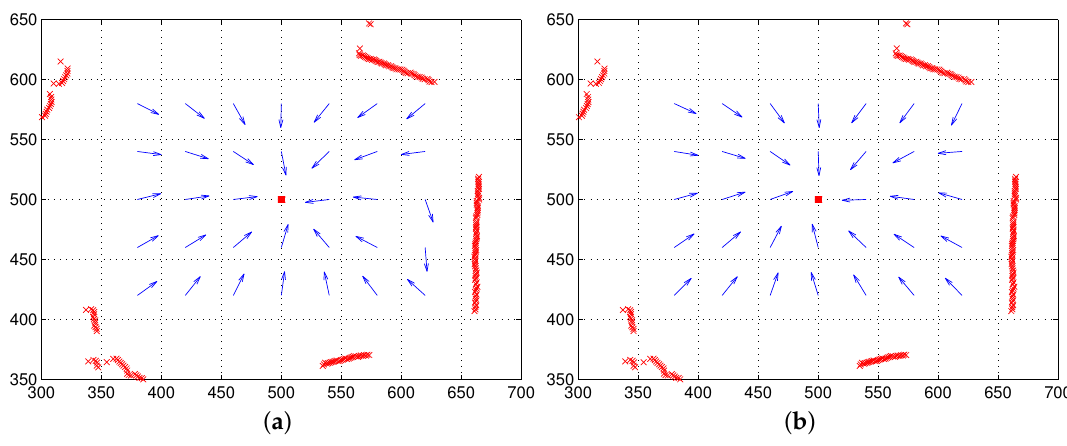
Figure 11. Homing performance of the moment model without a reference compass; both range data and color intensity are used, and the coordinate alignment process is applied: ( a ) visual compass; ( b ) landmark rearrangement method.